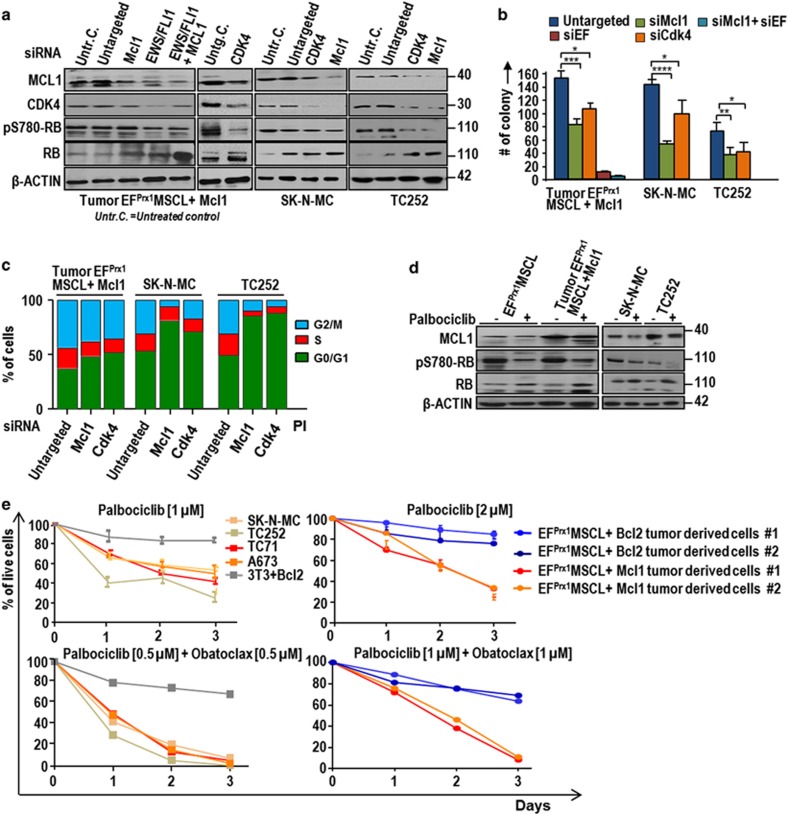
Knockdown of Mcl1 or Cdk4 induced cell cycle arrest and inhibited ES cell proliferation. (a) Mcl1 and Cdk4 siRNA analysis and expression check in murine and human ES cell lines resulted in upregulation of total RB and lower amount of pS780-RB. (b) Colony-forming assay in matrigel displayed reduced clonogenic potency of EF-dependent cell lines after knockdown of Mcl1 or Cdk4 by siRNA treatment. (c) Cell cycle analysis of Mcl1 or Cdk4 siRNA treatment displayed enhanced G1 arrest. (d) In vitro growth inhibition of mouse and human EF-dependent cell lines by Palbociclib as well as the combinatorial treatment of Palbociclib and Obatoclax in triplicate. Cells were treated with inhibitors at the indicated concentration for 24 h. (e) CDK4/6 inhibition by Palbociclib displayed similar results as seen in the CDK4 siRNA assay